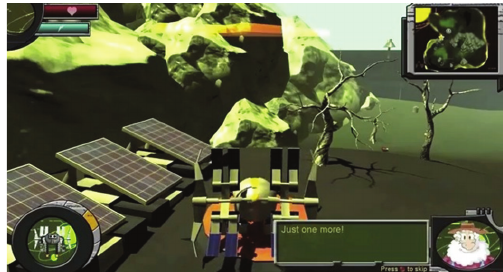
Figure 6: Screenshot of the third level, where the environment is less polluted.